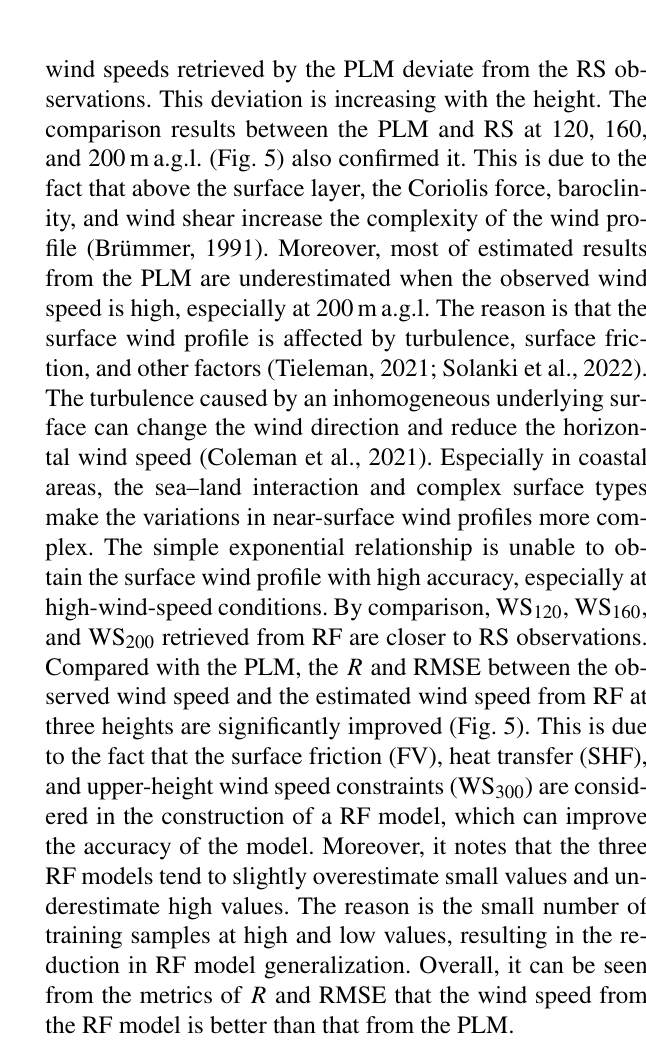
Figure 3. Importance analysis of inputs for the RF model at (a) 120m, (b) 160m, and (c)